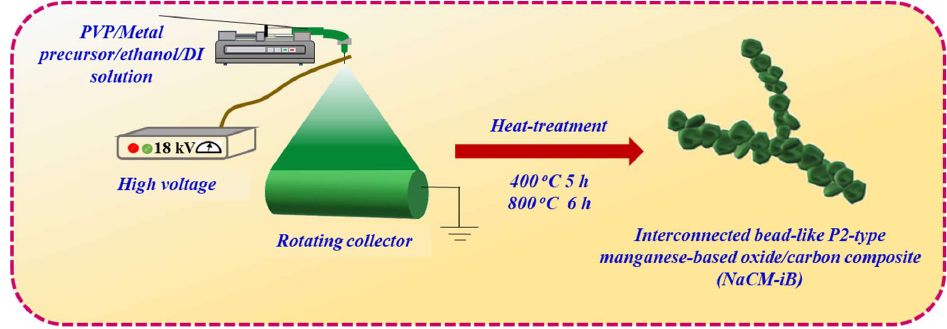
Figure 1. Schematic illustration of the synthesis of the NaCM -iB cathode material.